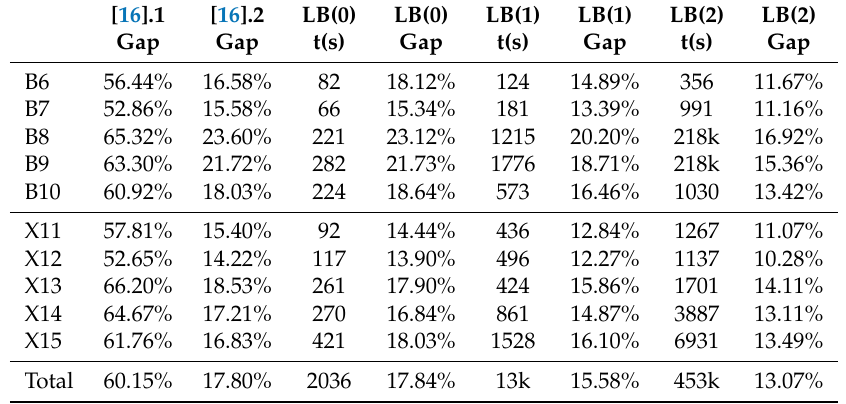
Table 8. Comparing with [16] the dual bounds using MILP computations of LB ( k 0 ) with k 0 <